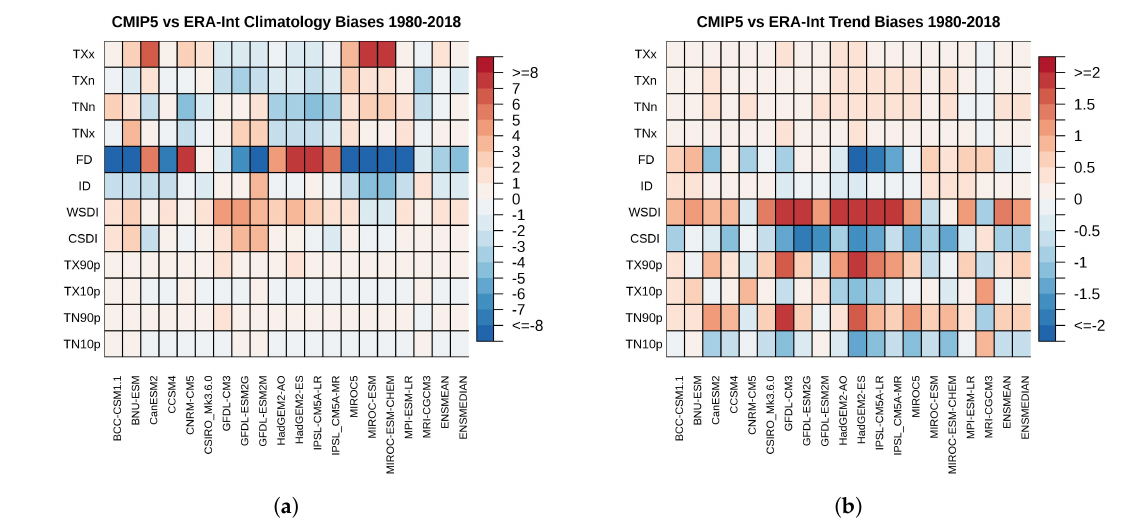
Figure 13. Portrait diagrams of biases of the 1980–2018 climatology ( a ) and the decadal trend ( b ) of temperature indices simulated by the CMIP5 models (RCP 4.5) with respect to ERA-Interim re-analyses. The biases are spatially averaged over MENA region land grid cells. The unit of the color bar scale refers to the respective unit of each